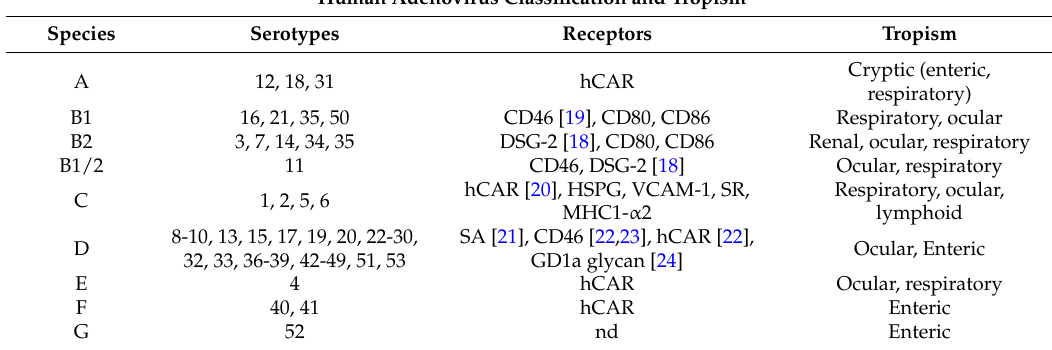
Table 1. Human adenovirus classification, receptor usage and tissue tropism. hCAR, human coxsackie and adenovirus receptor; DSG-2, desmoglein-2; HSPG, heparan sulfate proteoglycan; VCAM-1, vascular cell adhesion molecule 1; SR, scavenger receptor; MHC1, major histocompatibility complex class 1; SA, sialic acid; nd, not